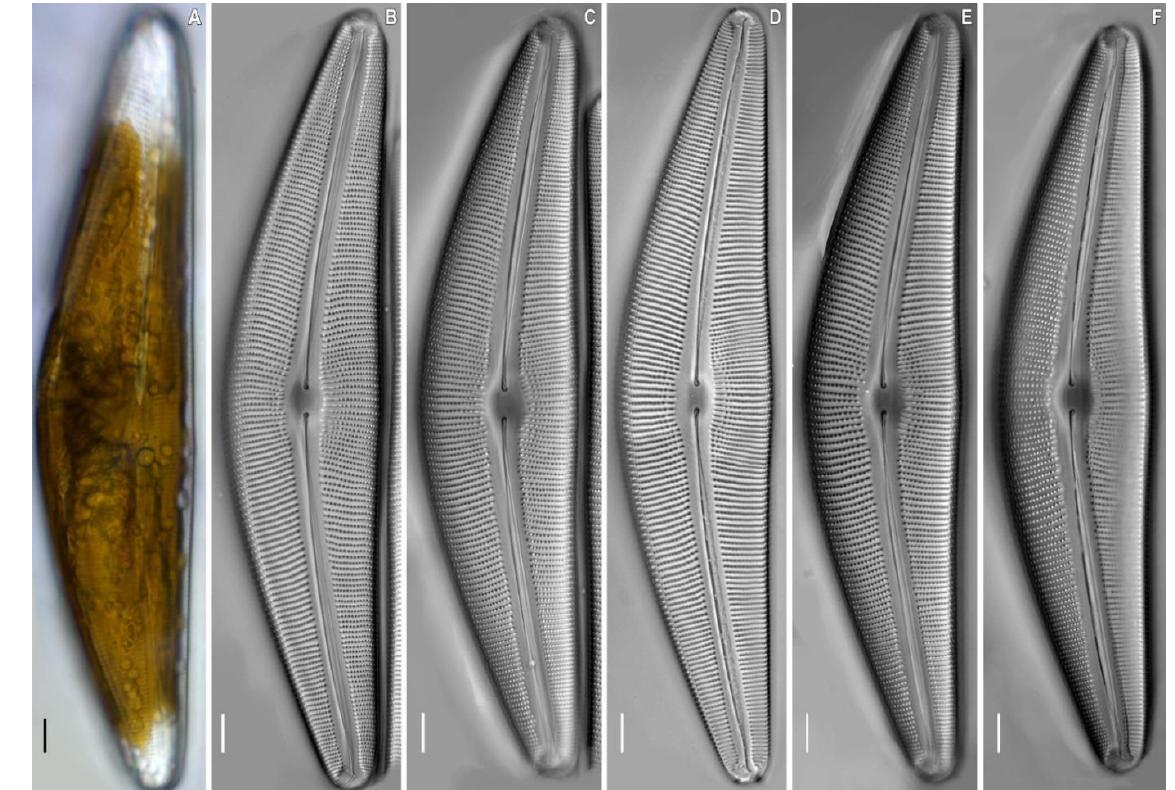
Figure 2. Cymbella himalaspera Jüttner and Van de Vijver in Jüttner et al. 2010. Strain B271. Light microscopy, differential interference contrast, size diminution series. ( A ) Live cells with chloroplast structure . ( B – F ) Oxidized material. Slide No. B271. Scale bars = 10 μm. Distribution. Nepal, Everest National Park [9] and Eastern Siberia, Buryatia (strain B271, slide no.